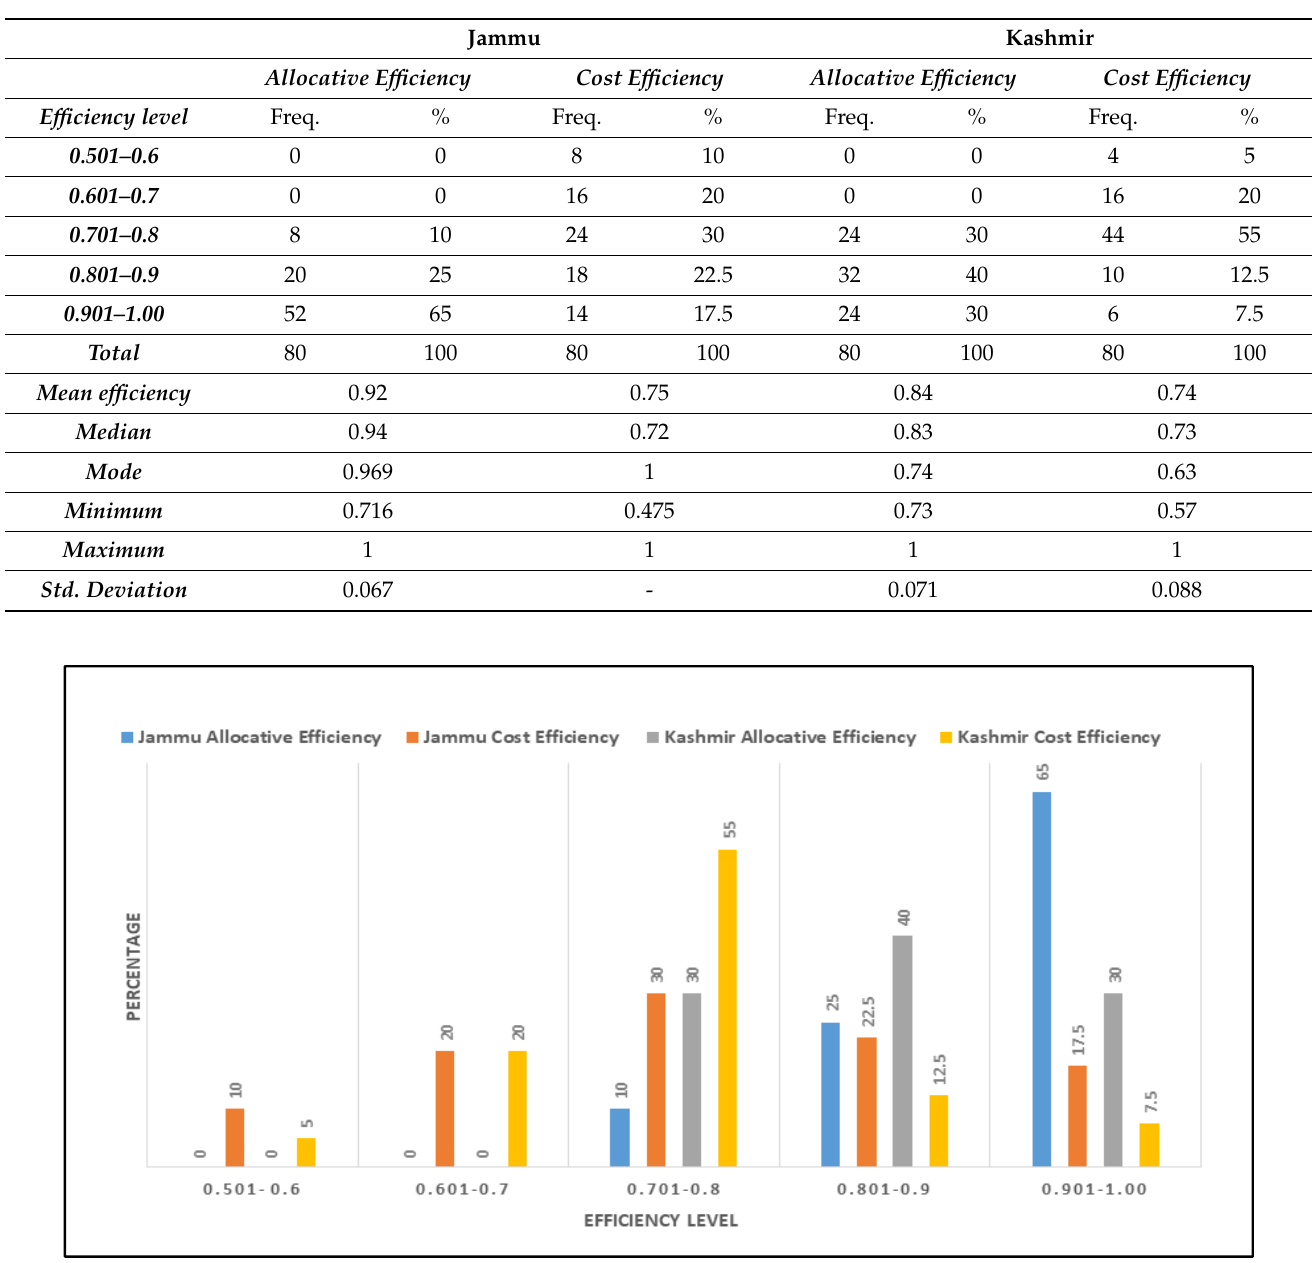
Table 6. Distribution of allocative and cost efficiencies of sample farms in the region.